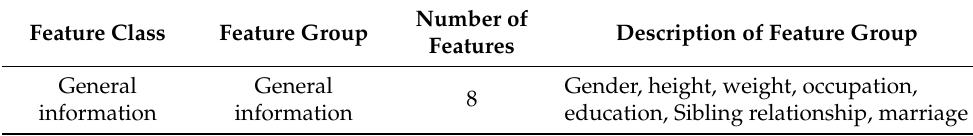
Table 2. A description of the feature classes and feature groups in the